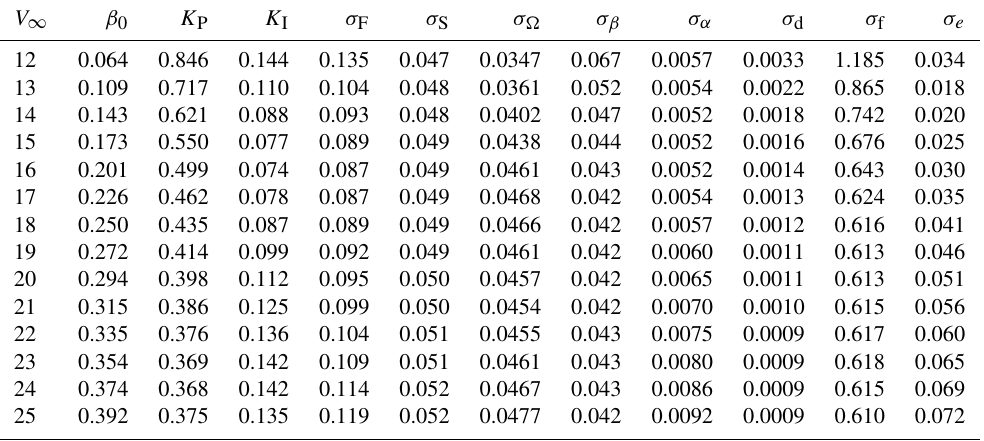
Table 4. The selected Pareto tuning and resulting metrics. The low-pass filter frequency f L is 0.17Hz in all cases. For abbreviations, please see the table in Appendix A.